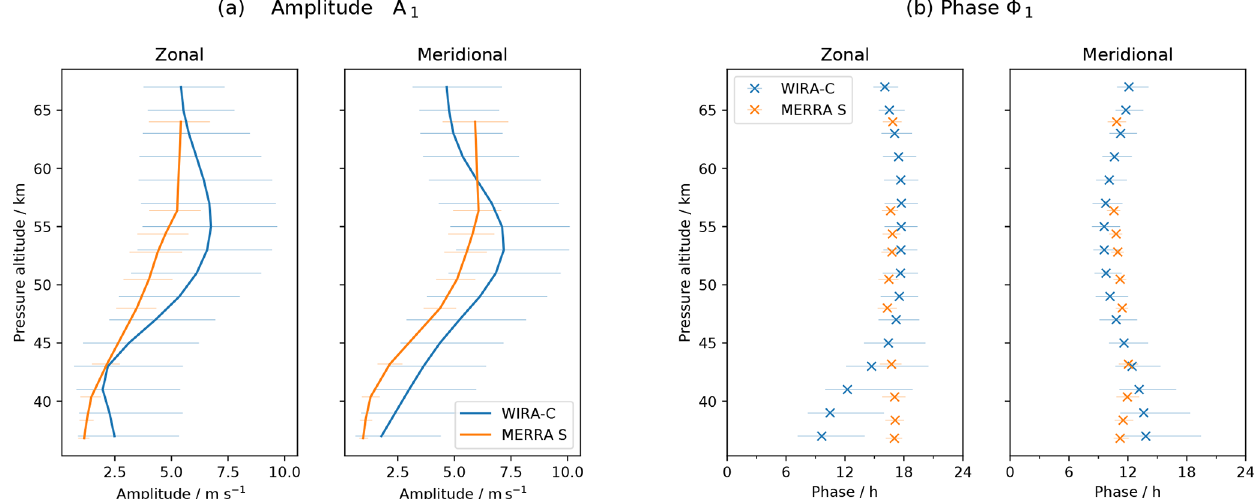
Figure 9. Amplitude and phase of mean daily cycle over 3 months from MERRA-2 reanalysis and WIRA-C measurements from the arctic campaign. Error bars indicate 95% confidence limits. Phase is equivalent to solar time of